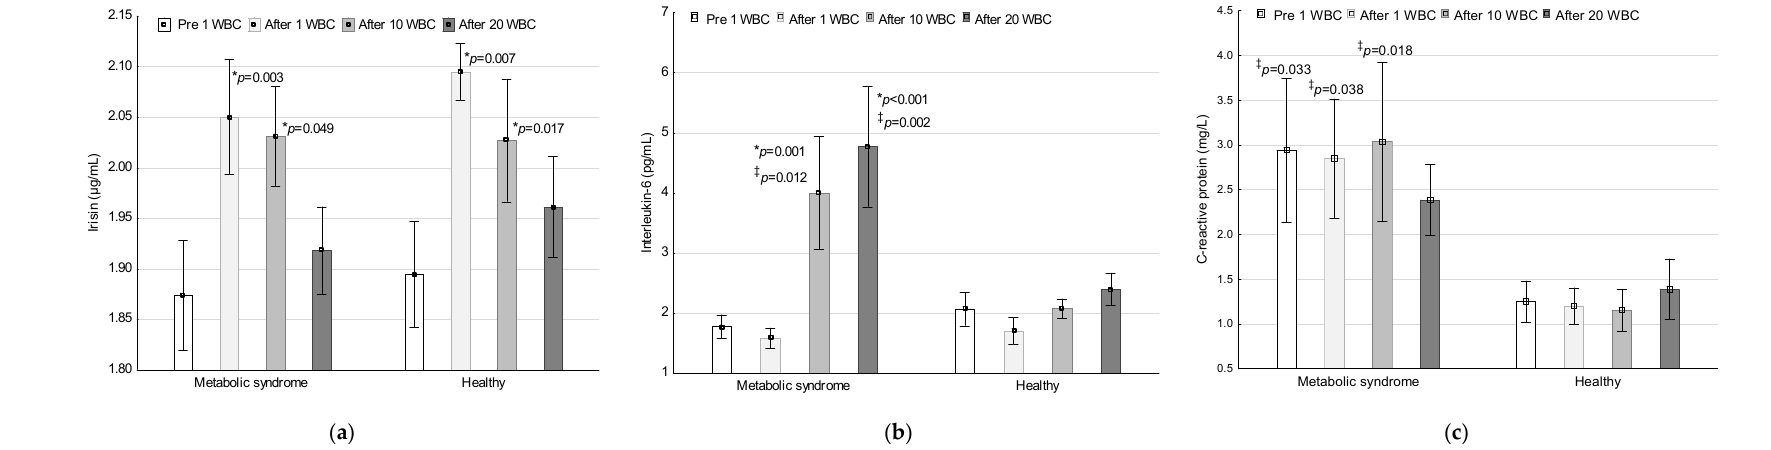
Figure 1. Comparison of concentrations: ( a ) Plasma irisin; ( b ) plasma interleukin-6; ( c ) serum C-reactive protein in the group with metabolic syndrome and in the group of healthy women during the application of whole-body cryotherapy (WBC) procedures. Data presented as mean ± standard deviation; * statistically significant differences compared to values prior to 1st WBC session ( p < 0.05); ‡ statistically signi fi cant di ff erences between groups ( p < 0.05).